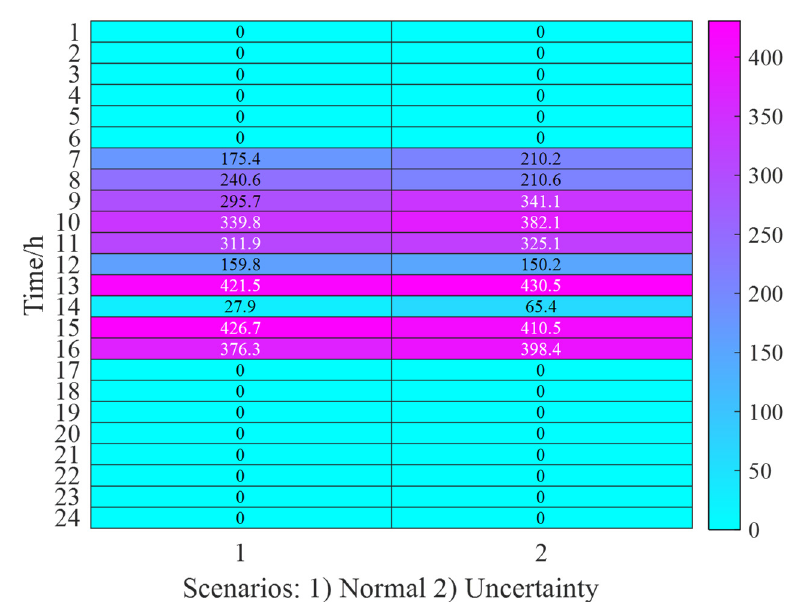
Figure 14. The output power of the PV system for both scenarios.